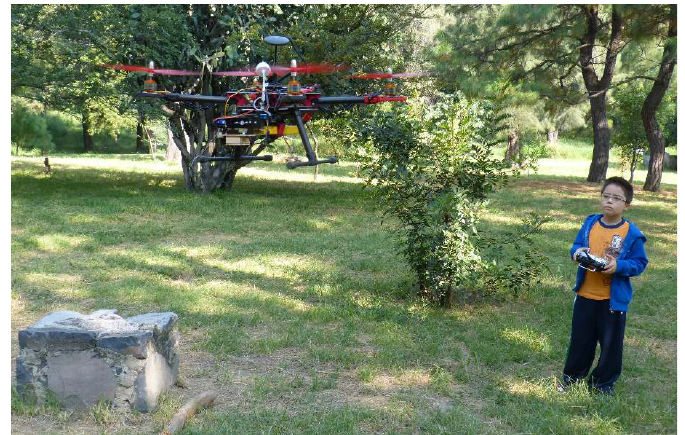
Figure 11. A park was used as flight field. Data obtained from the sensors of a radio-controlled quadrotor has been used to test the proposed method. The eight year-old first author’s son was in charge of piloting the flying